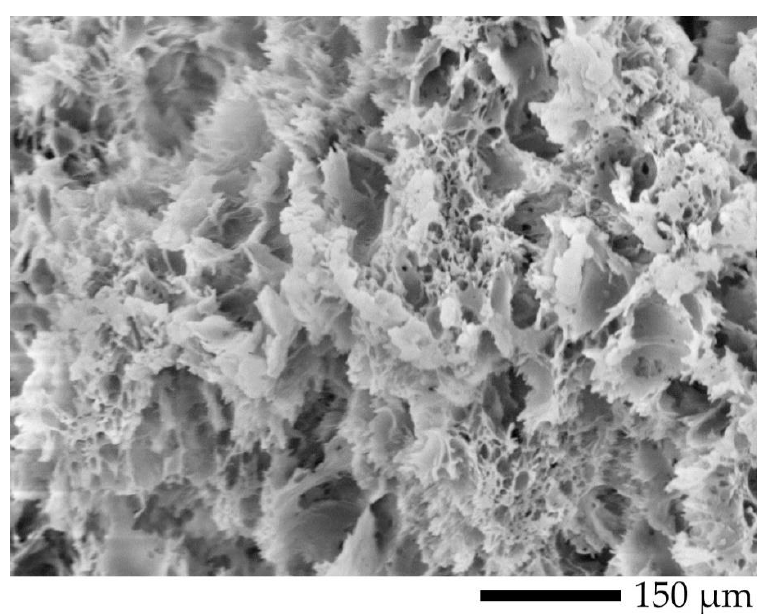
Figure 18. Tensile cracking morphology of L5V5 at the porosity of 43.4%.